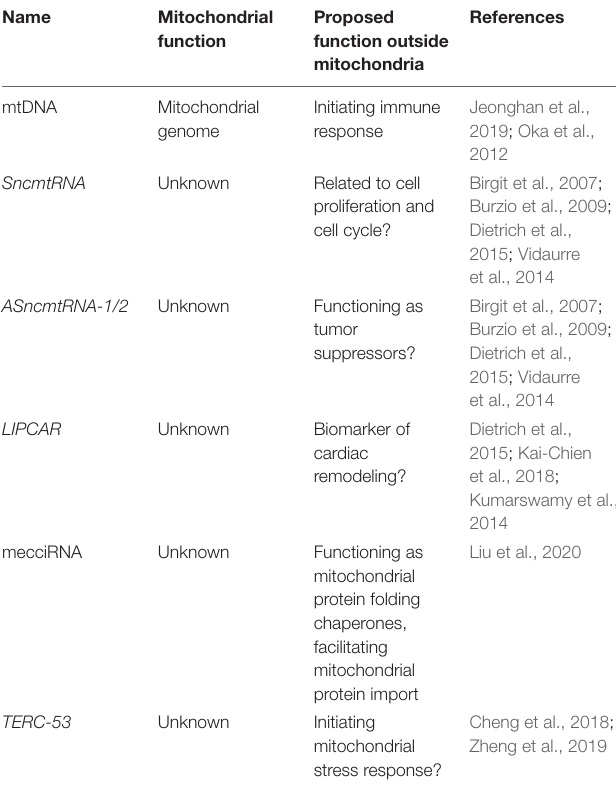
TABLE 2 | Mammalian mitochondrial RNA